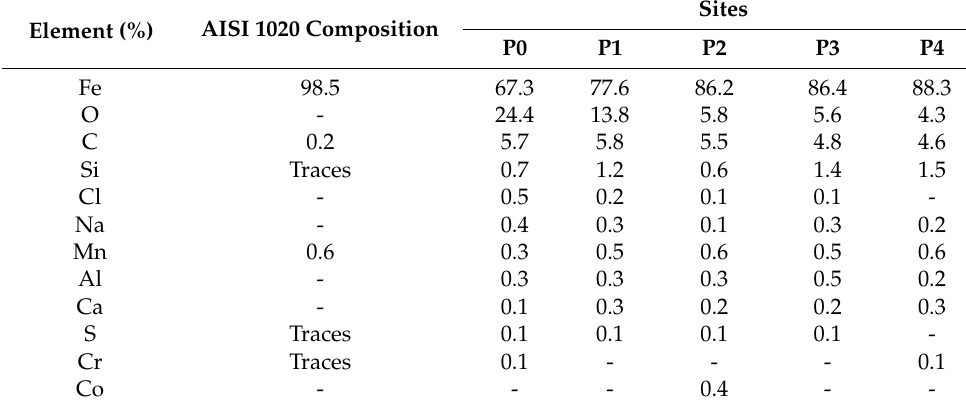
Table 3. Elemental analyses of the surface coupons after 32-day exposure, measured by EDS